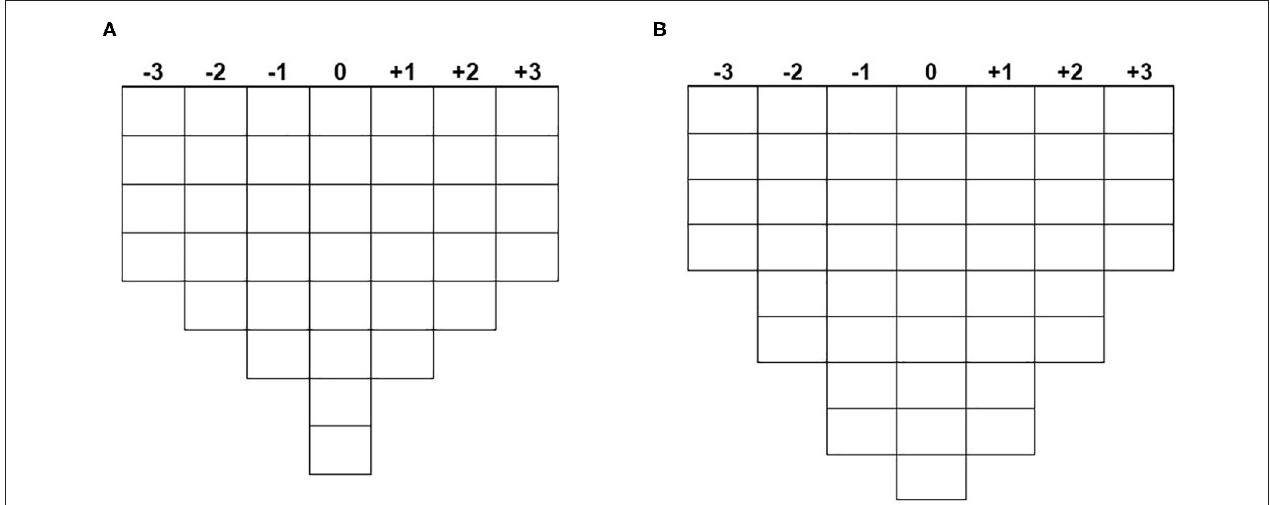
FIGURE 2 | Q-sorting. Breeders: 38 statements (A) ; drug vendors: 45 statements (B) .